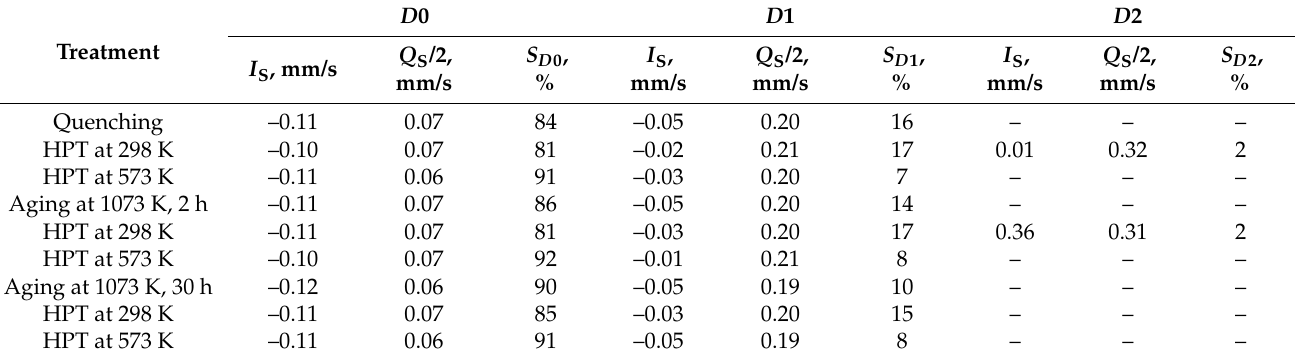
Table 1. Hyperfine parameters and integral intensities of FeMn 22 Cr 18 N 0.83 steel subspectrums in the initial quenched and aged at 1073 K, for 2-h and 30-h states and after HPT deformation ( n = 3 rev.) at 298 and 573 K. D Treatment